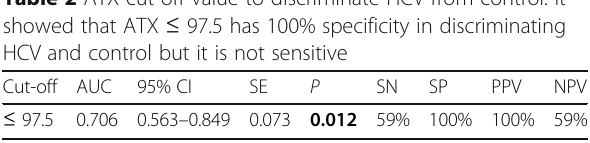
Table 3 ATX cut-off distribution in HCV and control: it showed that 100% of control subjects had ATX > 97.5 and 58.8% of HCV had ATX ≤ 97.5; a difference which is statistically significant ATX